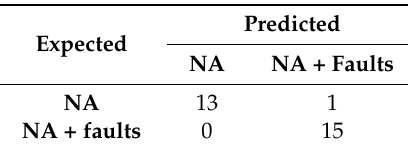
Figure 6. PCA-DA discrimination result among Negroamaro wines. Table 5. PLS-DA confusion matrix of original Negroamaro wines and wines with adulterations obtained by cross validation procedure.